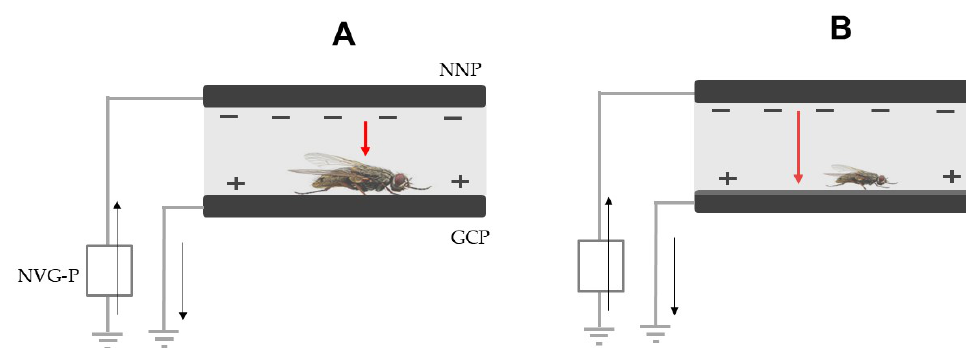
Figure 8. Schematic representation of preferential ( A ) and non-preferential ( B ) arcing to an insect in the electric field. The instrument consisted of a negatively charged non-insulated conductor plate (NNP), which was linked to a negative voltage generator (pulsed-charging type) (NVG-P), and a grounded conductor plate (GCP). ( A ) Larger insects were introduced into the electric field where a pulsed arc was generated and preferentially subjected to an arc discharge (red arrow) from the NNP. ( B ) No preferential arcing occurred to small insects, and the arcing occurred between the two plates as before. The black arrow indicates the movement of negative electricity.